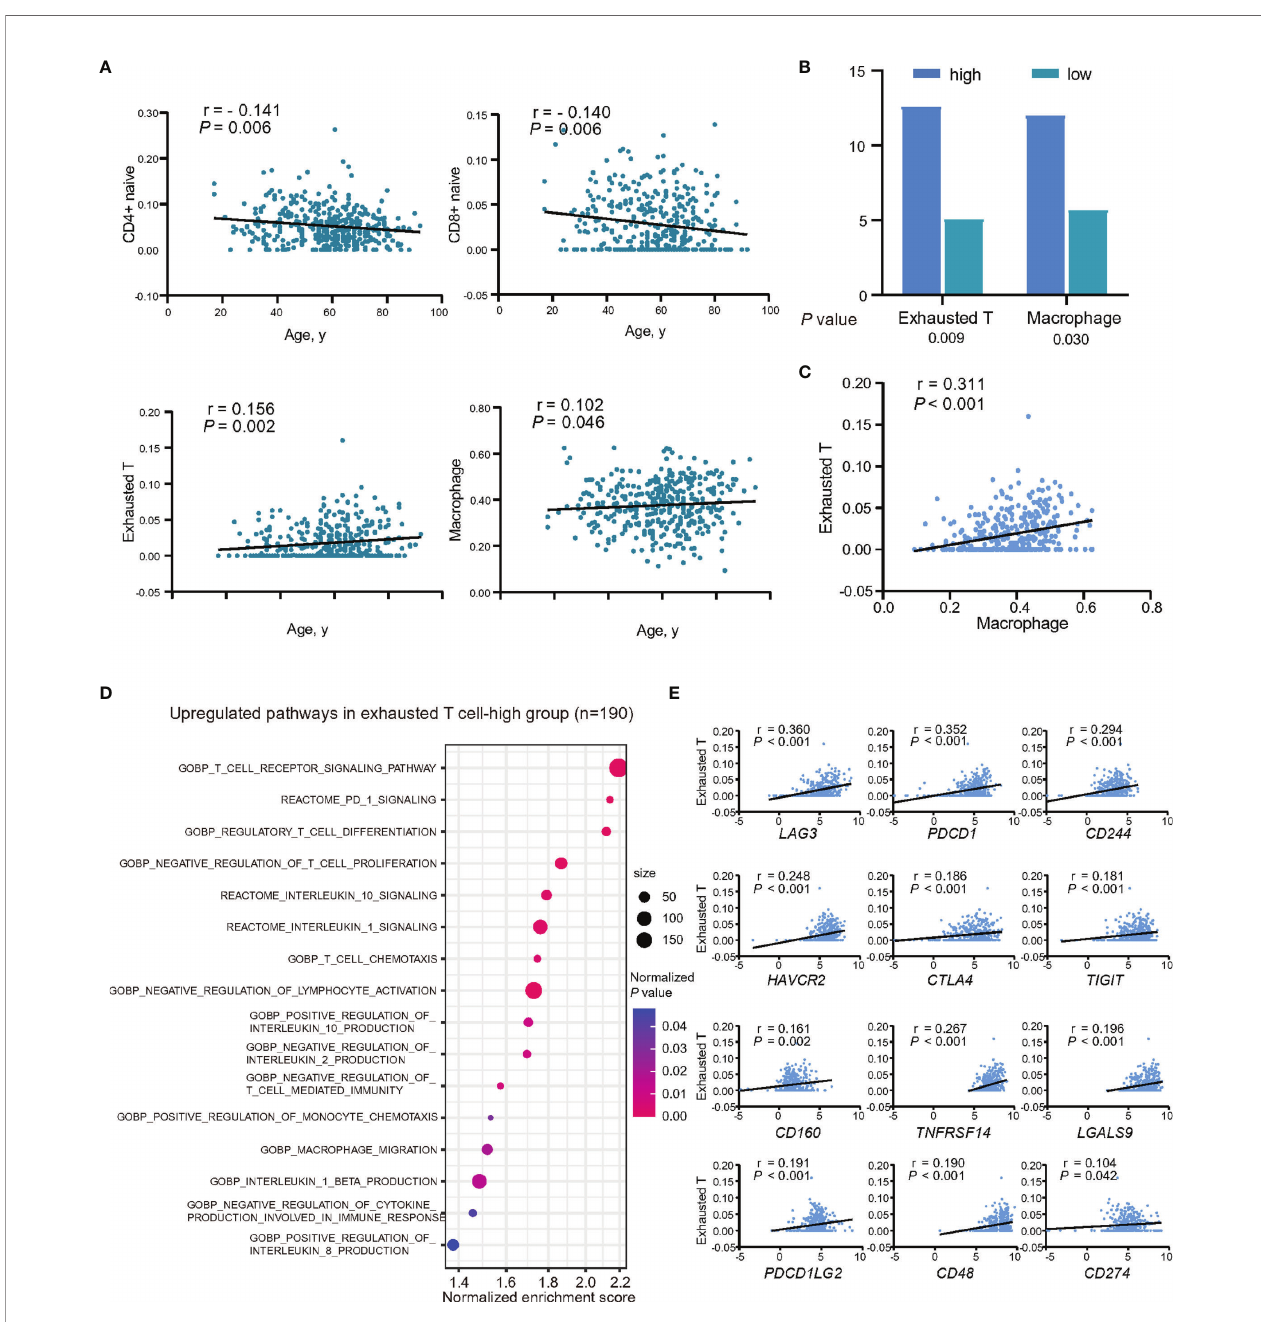
FIGURE 4 | Relationship between intratumor immune cells and age at diagnosis in DLBCL. (A) Abundance of immune cell subtypes in patients showing decreased or increased trend with age at diagnosis. (B) Mutation rates of CD79B between exhausted T-high group and exhausted T-low group, and also between macrophage-high group and macrophage-low group. Lower graph indicates P -values. (C) Correlation between the abundance of exhausted T cells and macrophages. P -value and r-value were indicated in the plot. (D) Pathway enrichment analysis in exhausted T-high group (n = 190), as compared to exhausted T-low group (n = 195, P < 0.05). Color of points indicates normalized P -value of upregulated pathways in two groups. Size of points indicates number of genes included in each gene set. (E) Correlations between the expression of inhibitory receptors, ligands, and the abundance of exhausted T cells. P -values and r-values were indicated in each